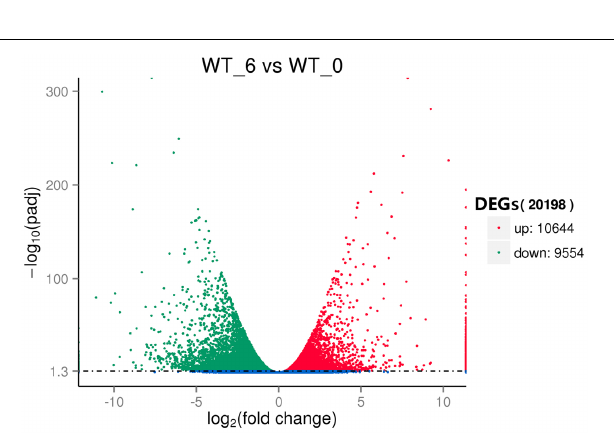
FIGURE 2 | Pathway assignment of perennial ryegrass genes based on the Kyoto Encyclopedia of Genes and Genomes (KEGG) database. (A) Classification based on cellular process categories, (B) classification based on environmental information processing categories, (C) classification based on genetic information processing categories, (D) classification based on metabolism categories, and (E) classification based on organismal systems categories.